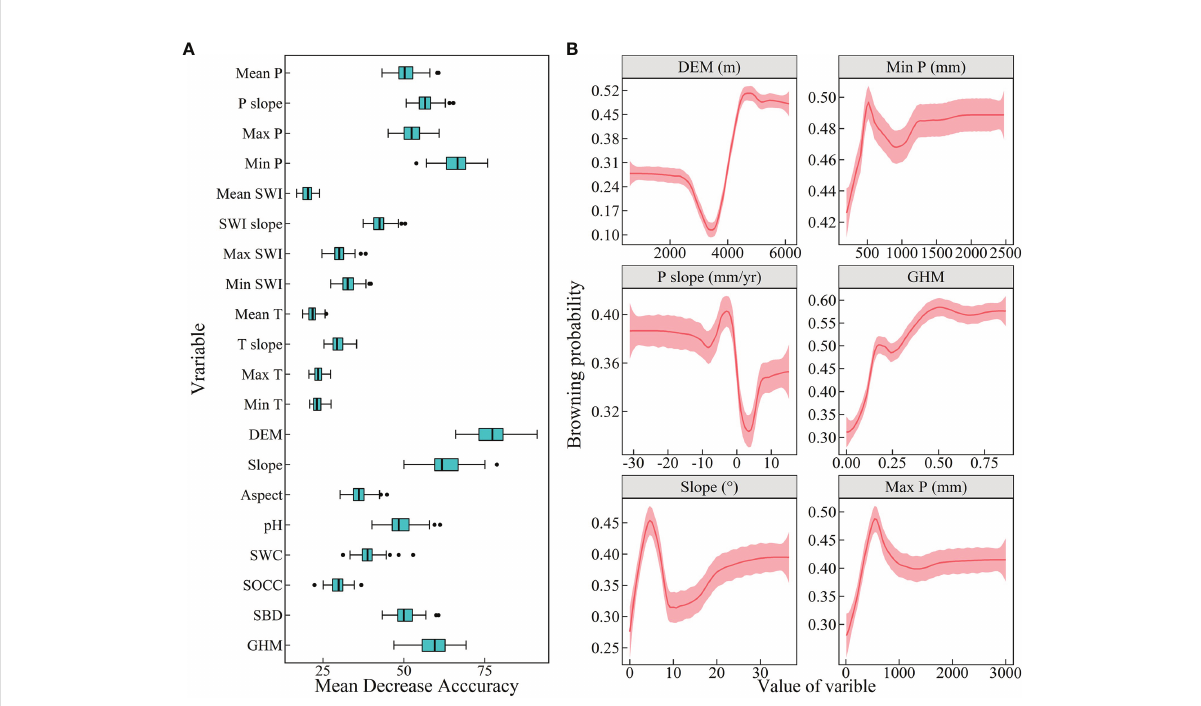
FIGURE 6 Feature importance and partial bias dependence maps of vegetation greenness browning on the Qinghai-Tibet Plateau. (A) Feature importance of 20 variables. (B) The top 6 drivers of feature importance were selected to plot their partial bias dependencies. The order of importance, from highest to lowest, is DEM, Min P, P slope, GHM, Slope and Max P. The light red area indicates the 95% con fi dence